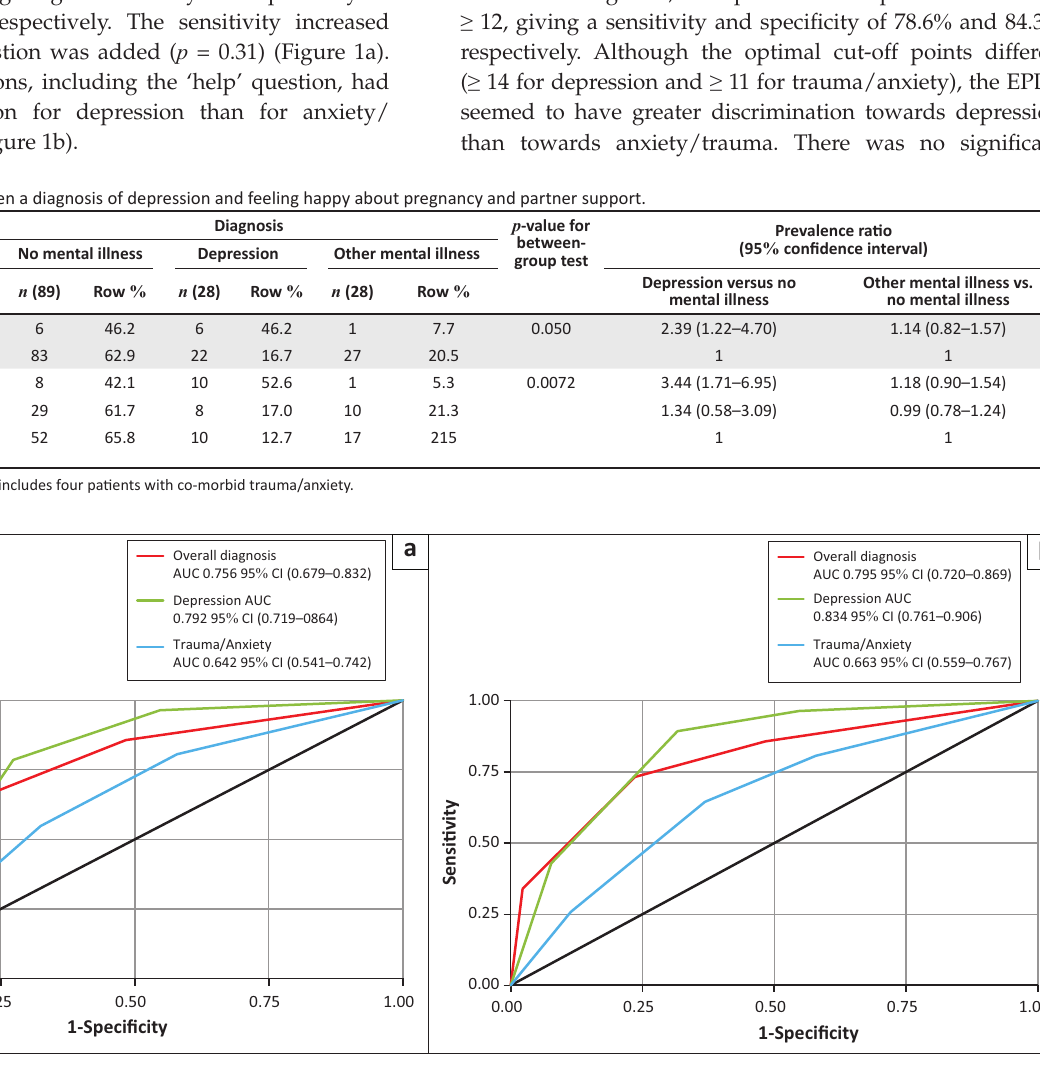
FIGURE 1: Comparison of ROC curves: ROC curve for the Whooley questions, (a) excluding the ‘help’ question and (b) including the ‘help’ question.